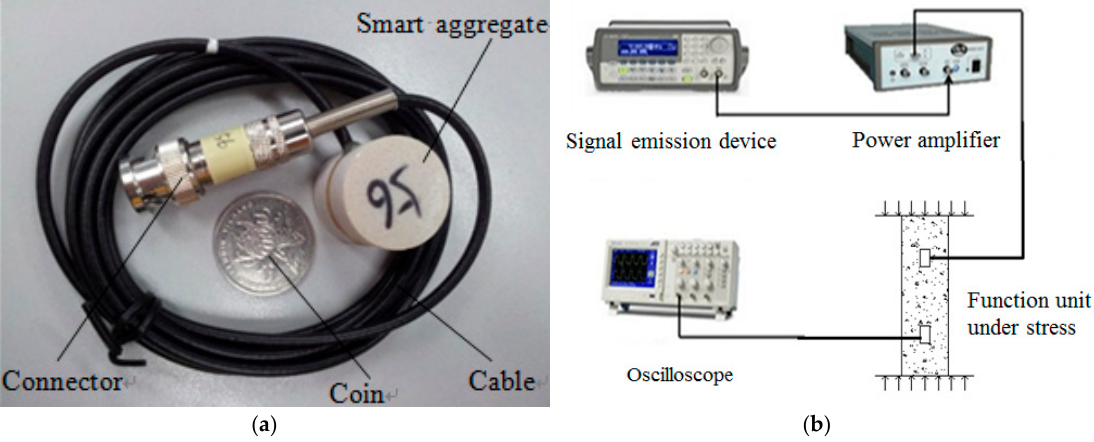
Figure 1. Monitoring system. ( a ) Smart aggregate with cable; and, ( b ) Test scheme.